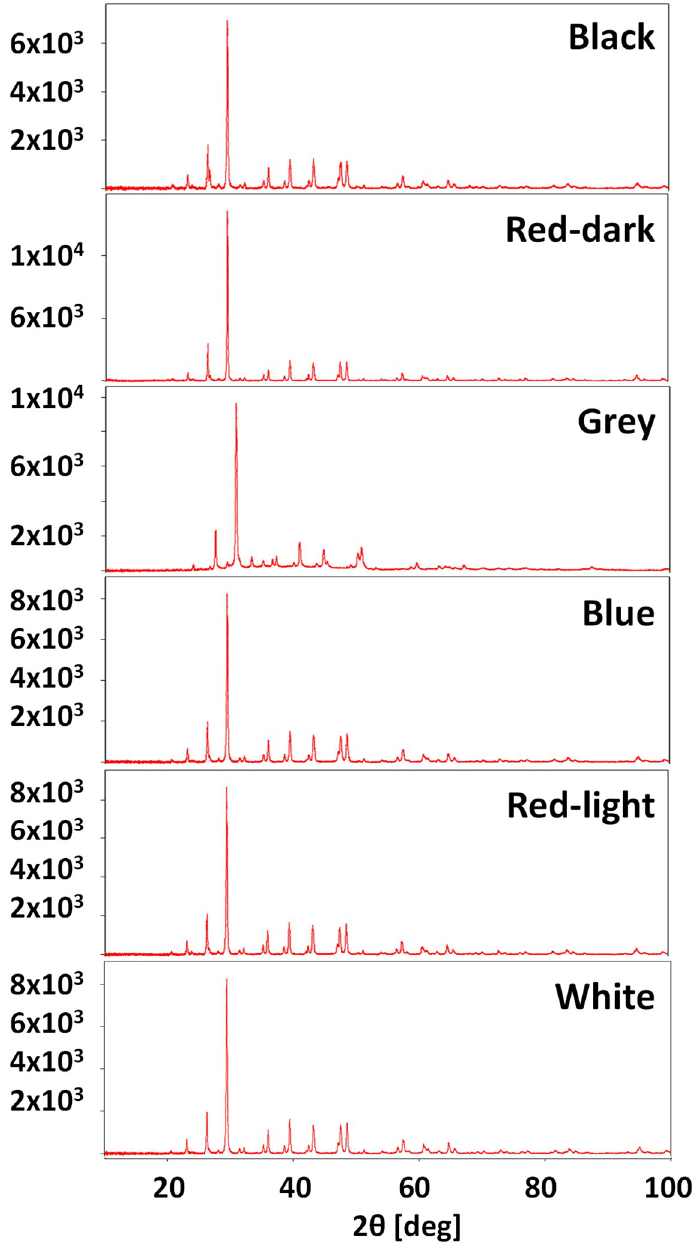
Figure 2. Characteristic XRD pattern for mosaic fragments.